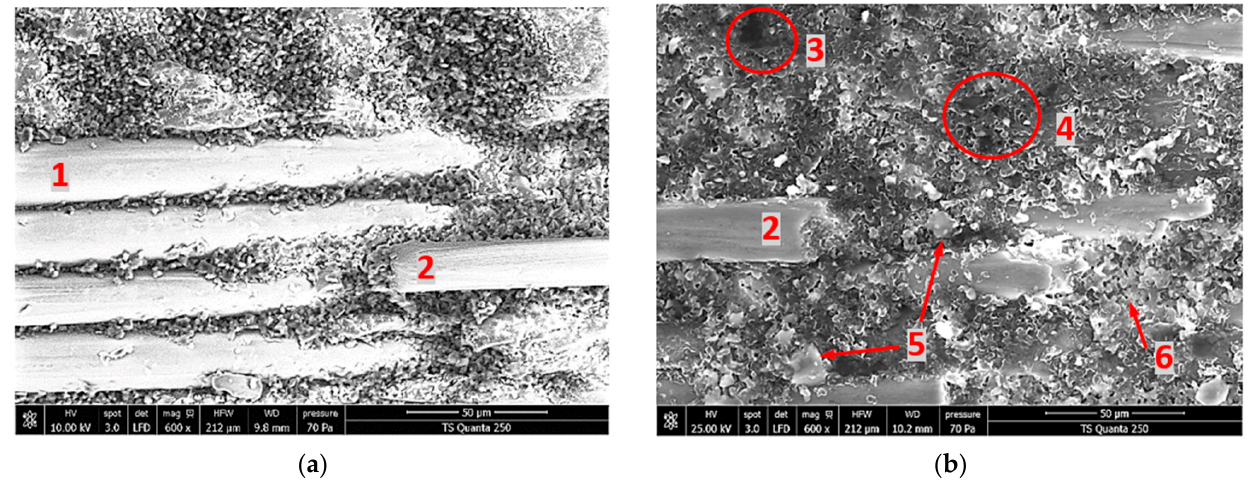
Figure 9. SEM Micrographs obtained when edge-trimming TCP composites parallel to fiber orientation. Legend : ( 1 ) uncovered fiber, ( 2 ) fractured fiber, ( 3 ) unfilled hiatus, ( 4 ) filled hiatus, ( 5 ) milled silica grains, ( 6 ) matrix debris. ( a ) Specimen B. ( b ) Specimen D.